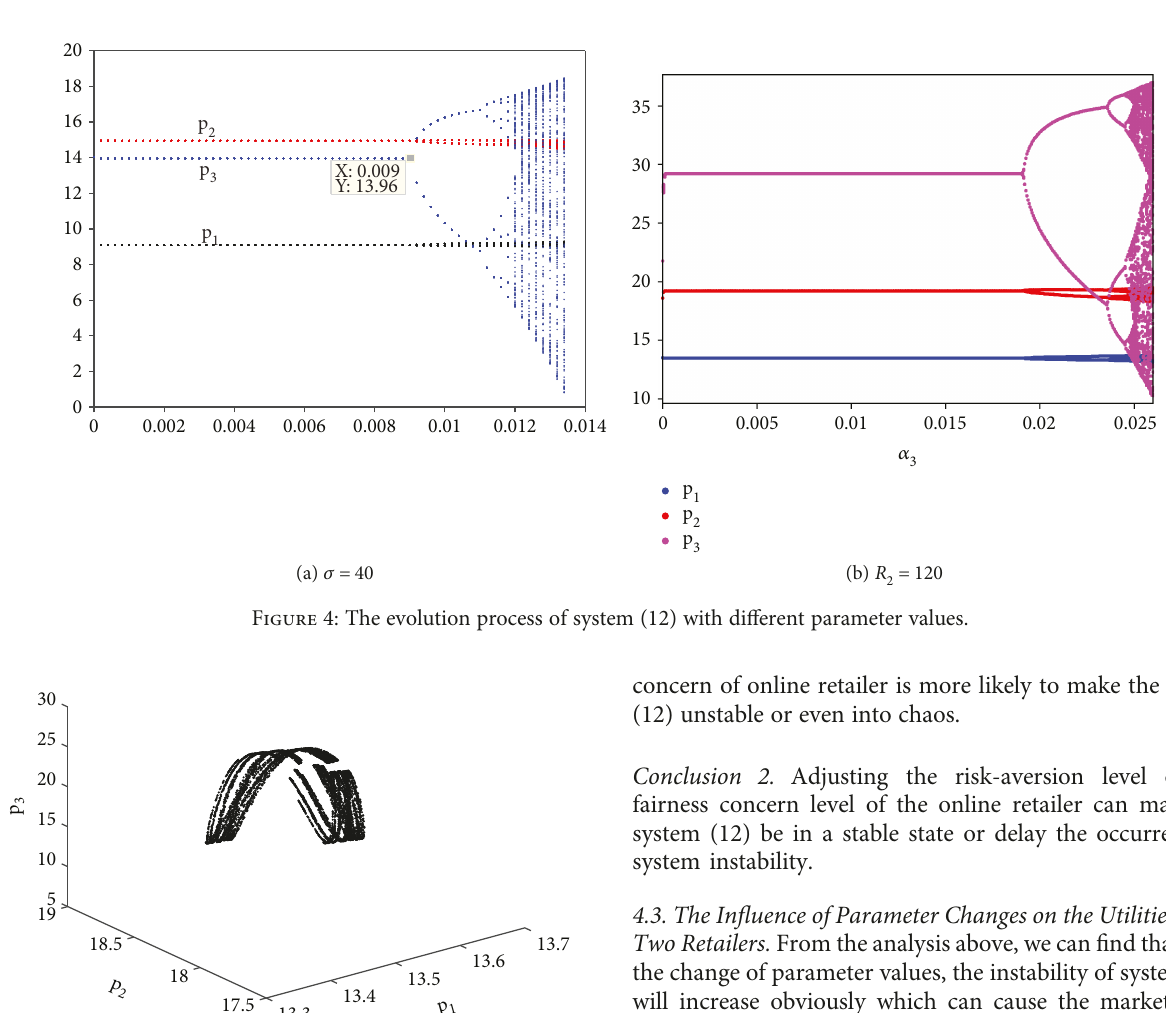
Figure 5: The chaotic attractor when α 0 0206 .